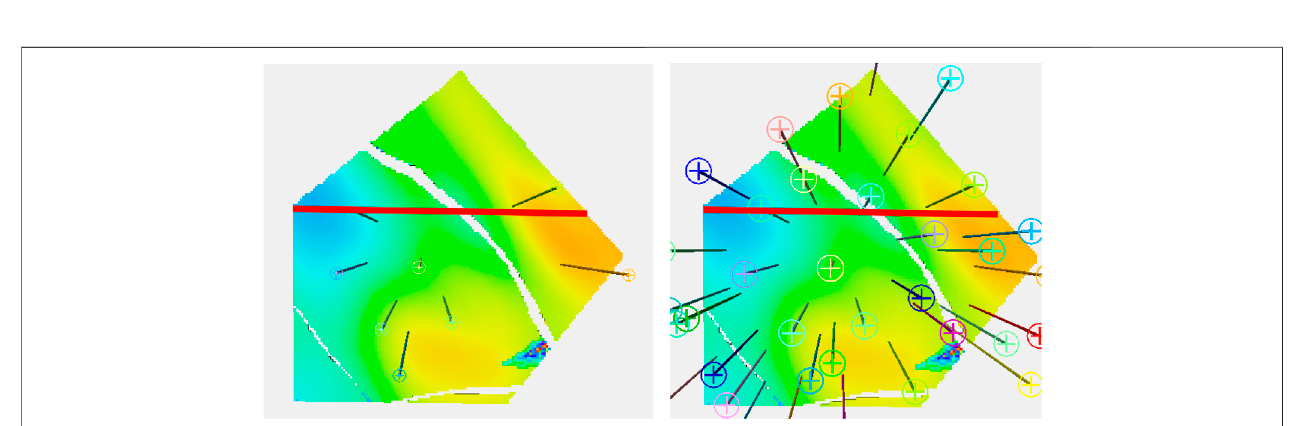
FIGURE 2 | Plan view with the 36-well con fi guration on the right and the eight-well one on the left.